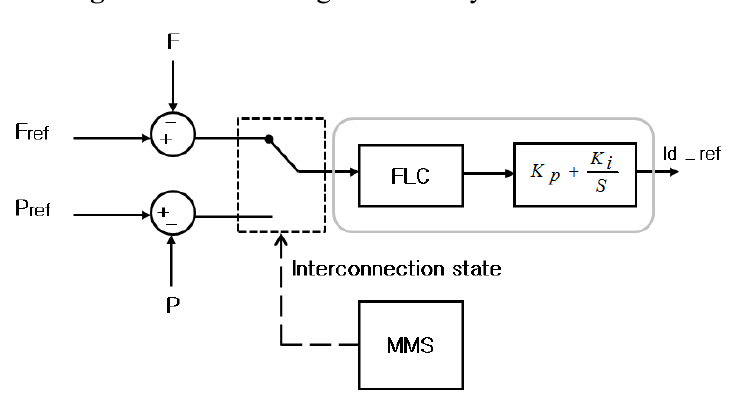
Figure 10. Block diagram of fuzzy PID